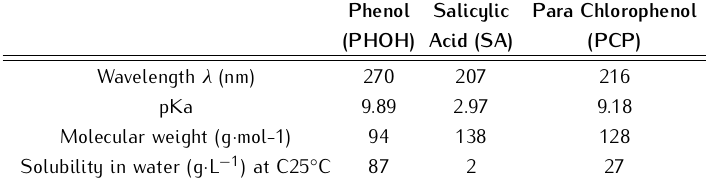
Table 2. Characteristics of